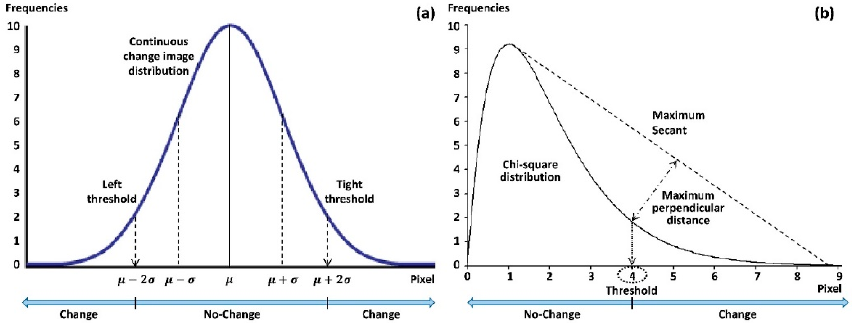
Figure 7. Definition of thresholds values by ( a ) Statistical parameters, and ( b ) Secant method.